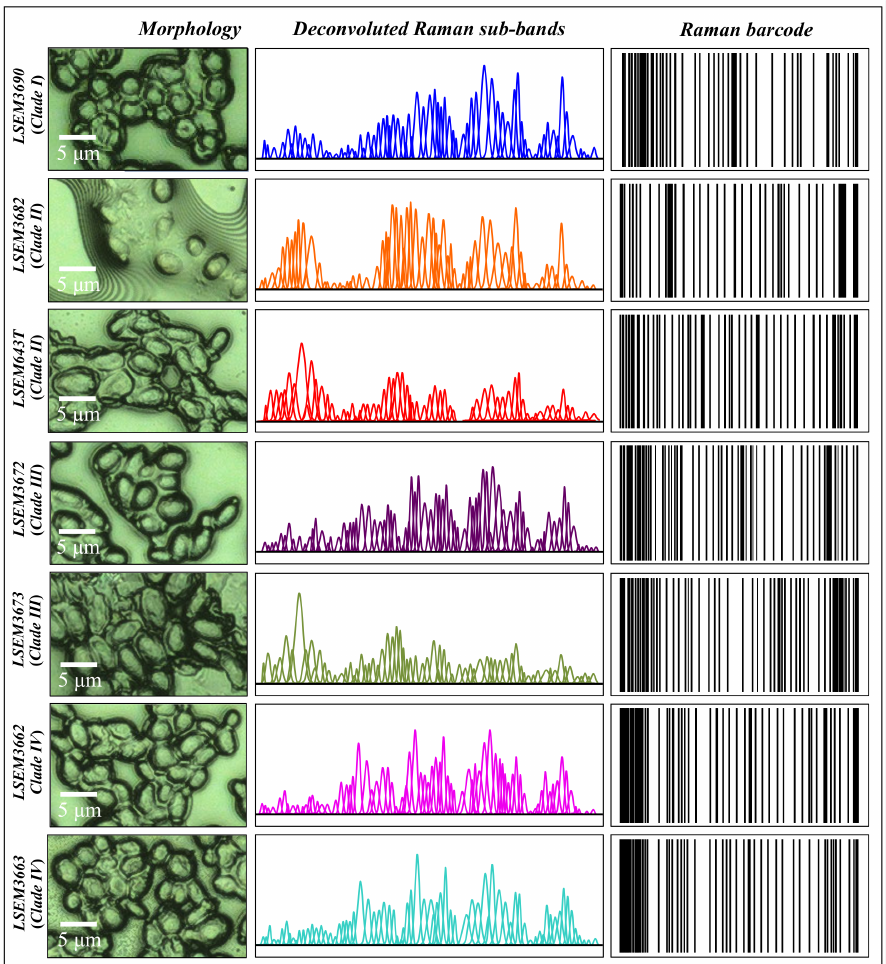
Figure 12. From left to right: high-resolution micrographs of different C. auris clades/subclades (cf. labels in inset), series of Gaussian–Lorentzian subclades (i.e., the same as those shown in the deconvoluted spectra of Figure 2) obtained from a machine-learning-based spectral deconvolution (cf. Section 2.3) for each sample, and Raman barcodes computed from the respective sub-band sequence according to the algorithm described in Section